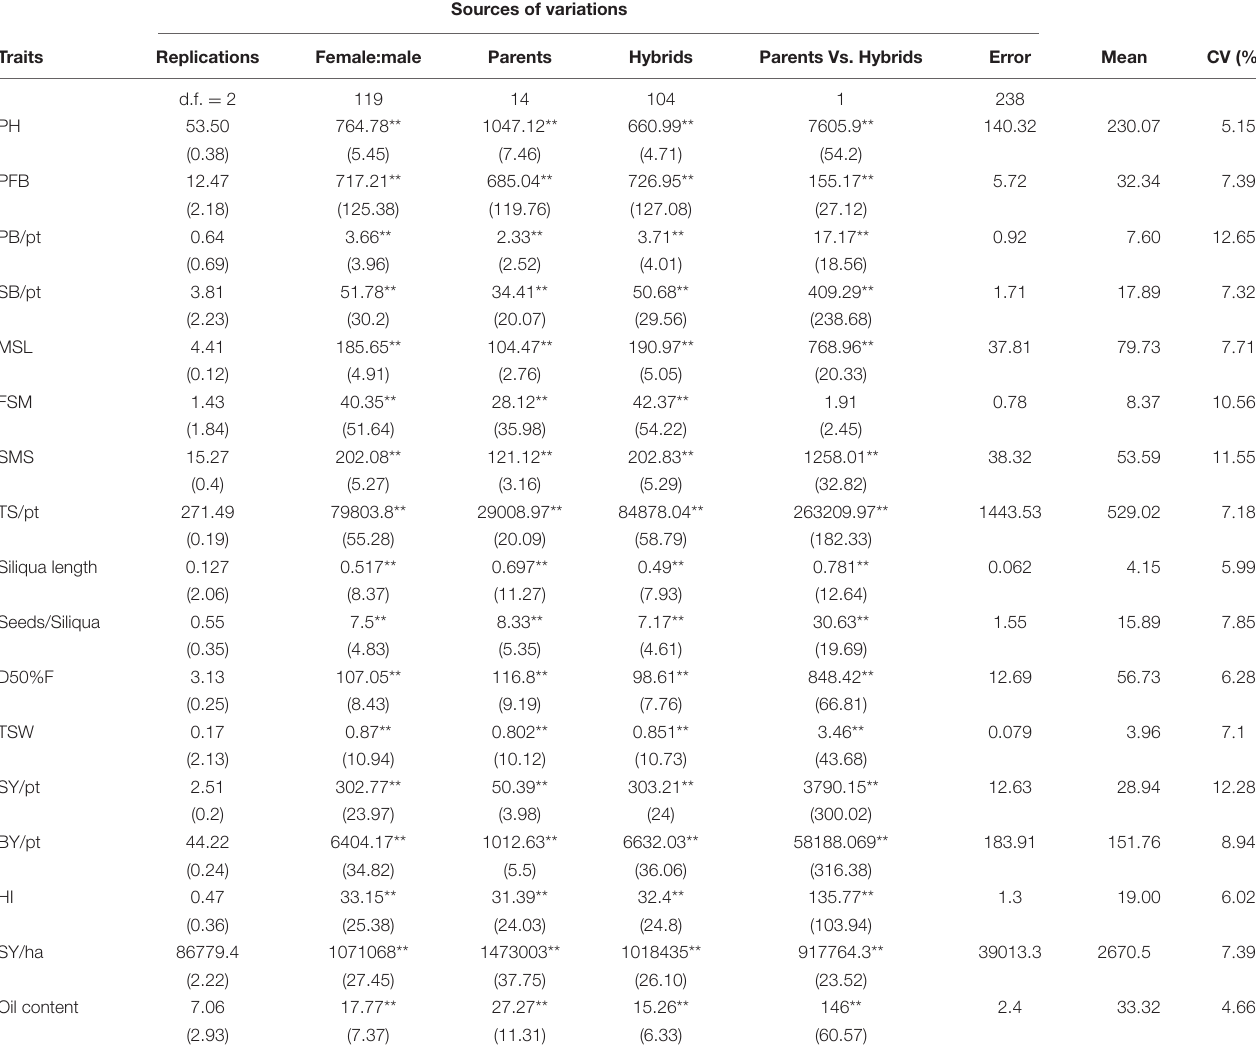
TABLE 1 | Analysis of variance for parents and hybrids generated in half diallel design for studying different yield contributing traits under irrigated conditions.